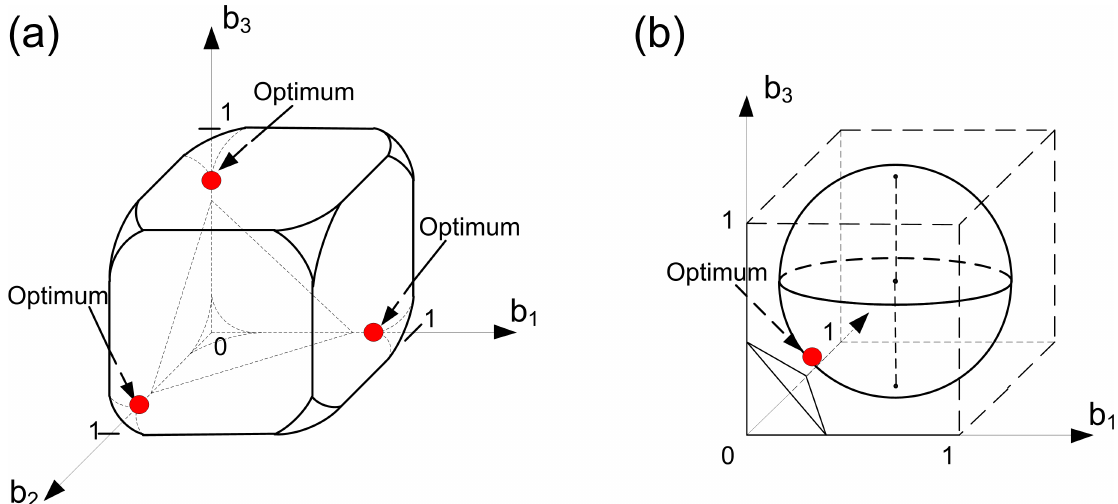
Fig 3. Evolution of germ and soma in colonies with identical cells: A convex trade-off, a resource constraint and different ‘importances’ of viability and fecundity (Case 3). Here we assume that we have three groups of cells within the colony such that all cells from each group have the same level of fecundity and the same level of viability (i.e., we have three ‘aggregate’ cells in the colony). Optimal strategies of the colony are colored in red. The evolution of structural complexity in unspecialized large-sized colonies can lead to the emergence of soma specialization (panel (a)) as well as to unspecialized optimal states in the case of environmental quality degradation (panel (b)). In both panels, k 1 = k 2 = 1, α = 1 and φ = ( b- 1) 2 . In panel (a), β = 4 and C = 2.85. In panel (b), β = 4 and C = 2.5.